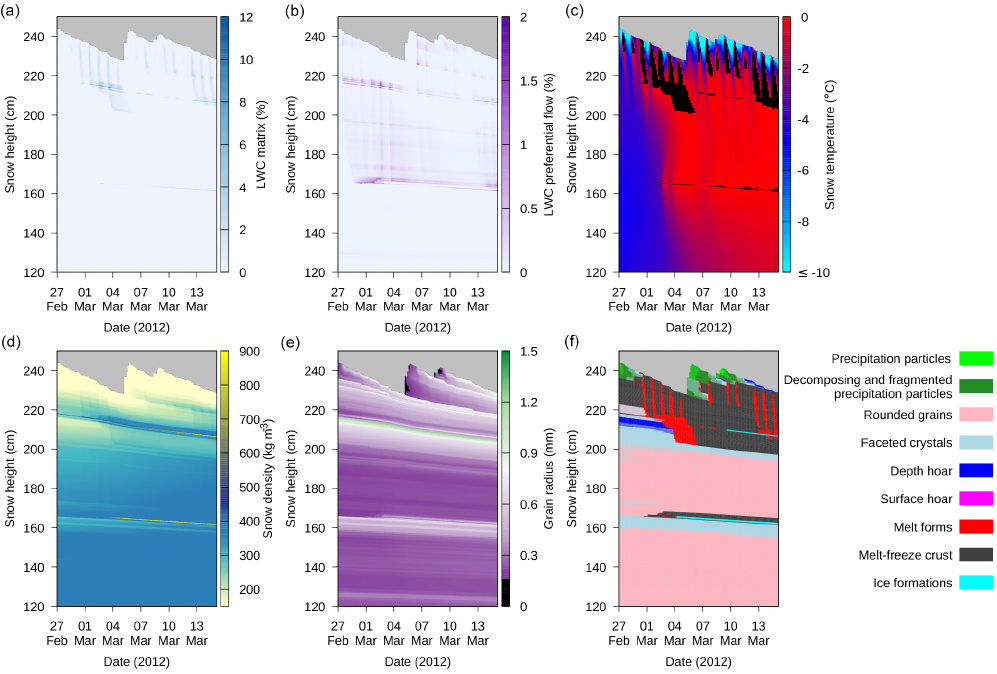
Figure 6. LWC in matrix domain (a) , LWC in preferential flow domain (b) , snow temperature (c) , snow density (d) , grain radius (e) and grain shape (f) , depicting a detail of Fig. 5. Only the upper part of the snowpack is shown for the period 27 February to 15 March. In (c) , snow at melting temperature is coloured black to highlight wet parts; in (e) , grain radii smaller than 0.16mm are coloured black, denoting the smallest grain size class used in Katsushima et al. (2013); and in (f) , ice formations are defined as modelled dry snow density exceeding 700kgm − 3